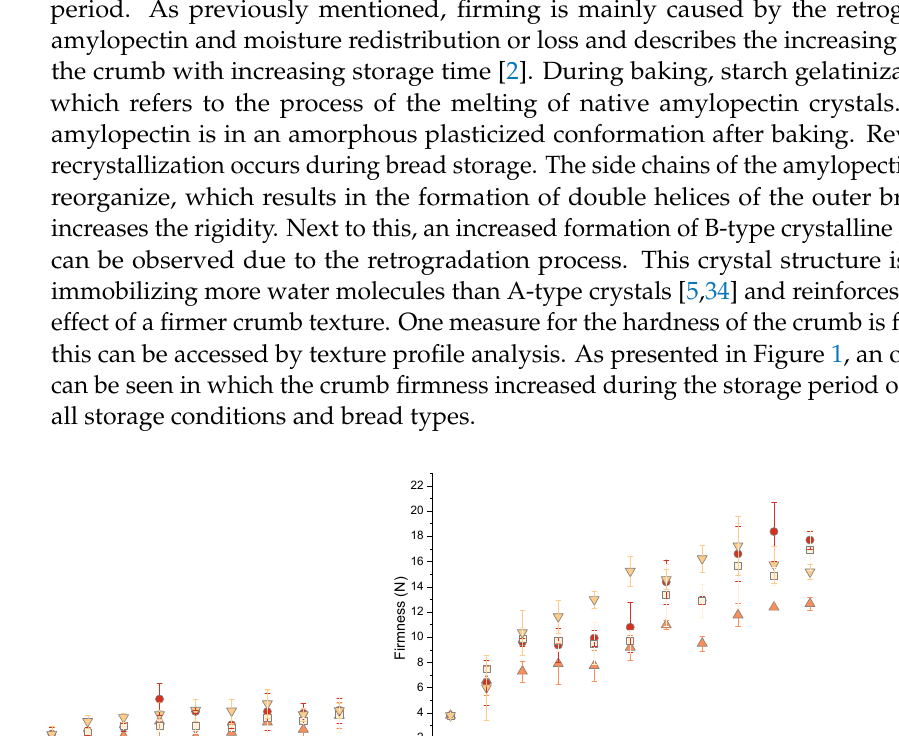
Table 2. Absolute moisture loss of bread samples (crumb and crust) for different storage conditions and bread types after a storage period of ten days. ( x(cid:3364) ± STD, n = 3). Absolute Moisture Loss of Pan PE-layered microperforated paper bag (21.3